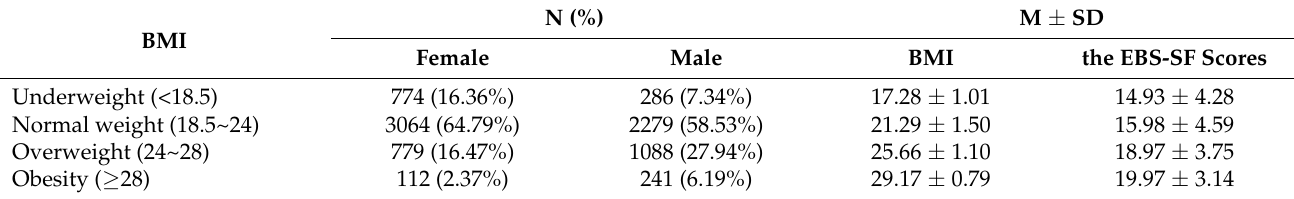
Table 4. The statistical description of BMI and the EBS-SF